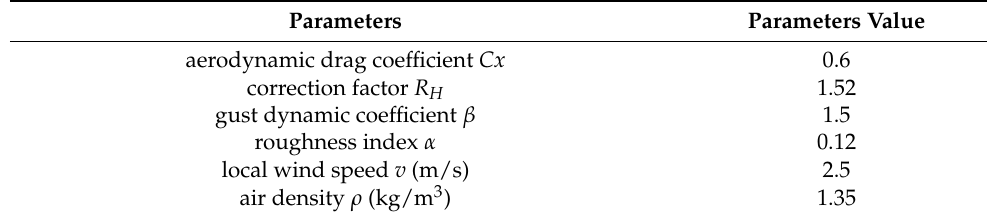
Table 1. Calculation parameters of wind load torque.